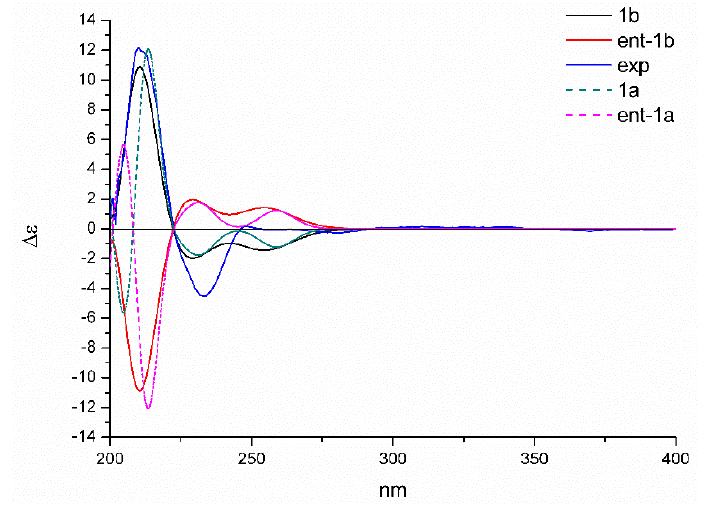
Figure 5. Calculated and experimental electron capture detection (ECD) spectra of 1 in methanol.